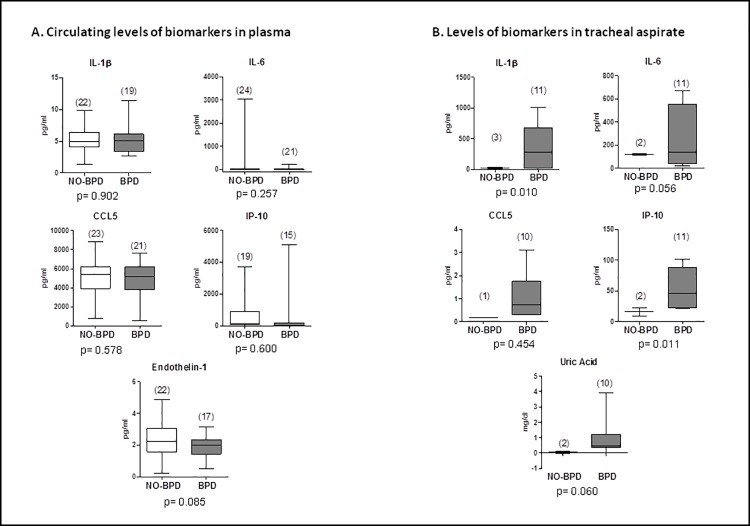
A. Levels of biomarkers in plasma of BPD (moderate/severe BPD or death) patients compared with no-BPD patients (no BPD or mild BPD) at day 7 of life. B. Comparison of the levels of biomarkers in bronchoalveolar lavage of intubated patients between the BPD and no-BPD group, at day 7 of life.